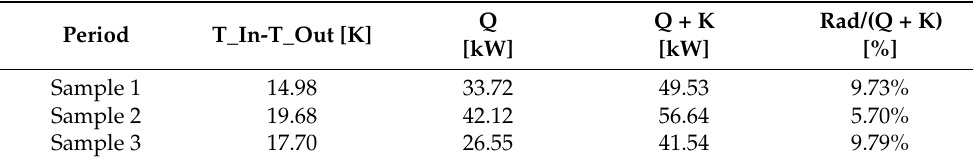
Table 4. Thermal conditions for the three periods analyzed. All variables are averaged for the period.